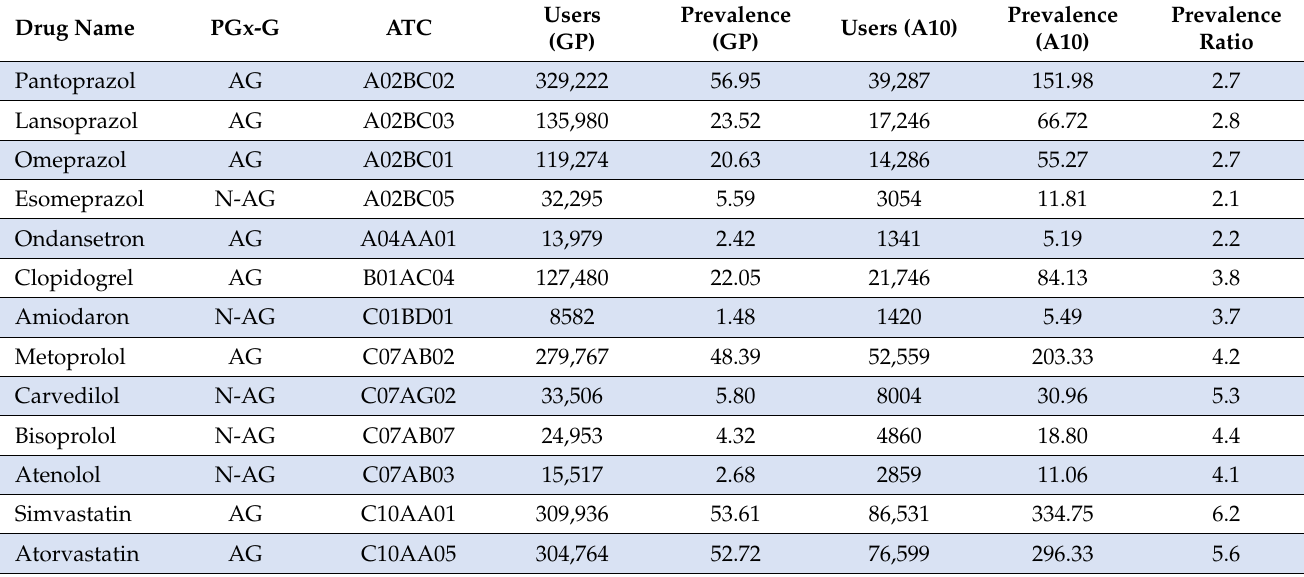
Table 4. Consumption of PGx drugs in the general population (GP) and among persons with diabetes